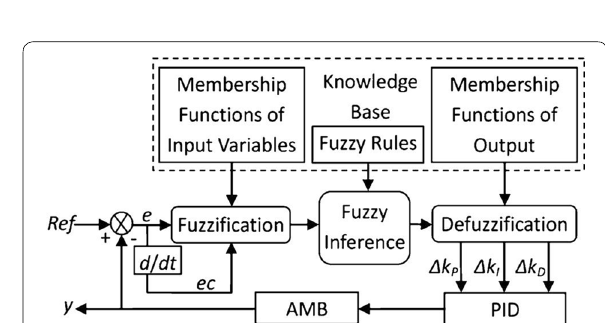
Figure 23 Active control model of rotor-bearing system established by Yang et al. [94]